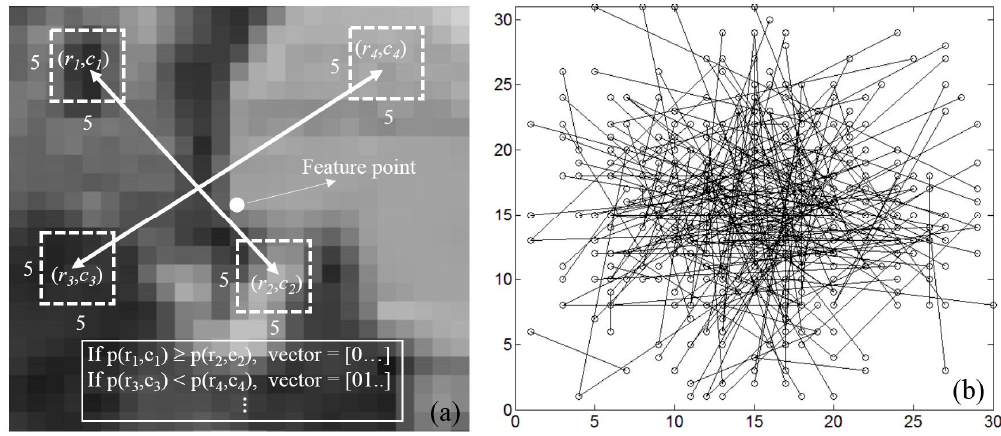
Figure 2. ( a ) Operation processing of the BRIEF descriptor; ( b ) its 256 pixel-pairs.